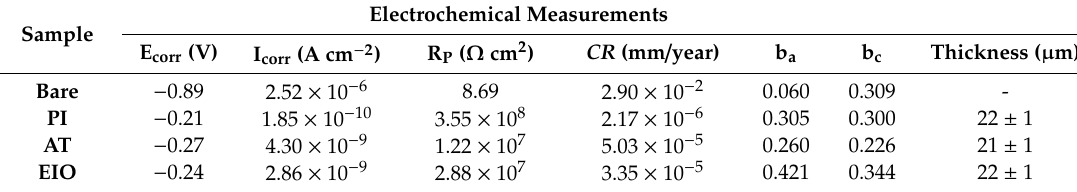
Figure 5. Tafel plots for the PI, AT and EIO coatings measured in 3.5 wt.% NaCl solution for ( a ) 1 day and ( b ) 30 days. and ( b ) 30 days. Table 2. Electrochemical parameters derived from Tafel plots of the coatings in the saline solution after one-day immersion.